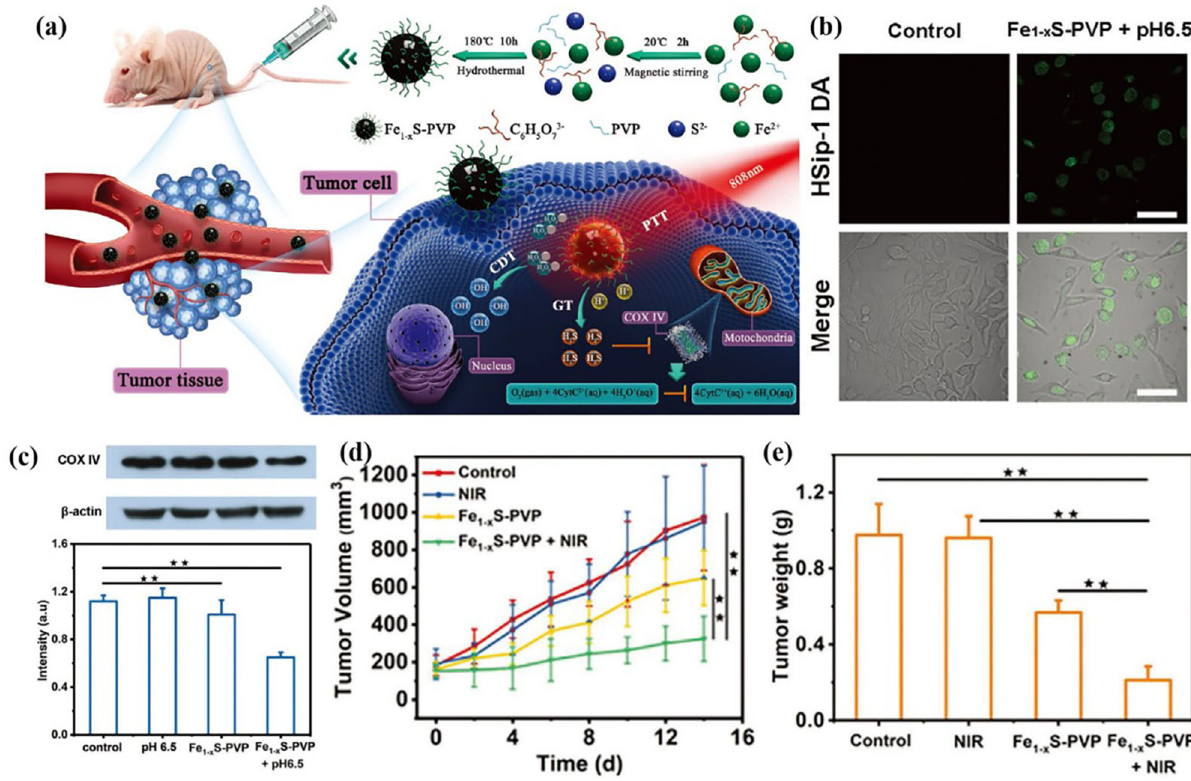
Figure 4: ( a ) Schematic illustration of the Fe 1 − x S - PVP - mediated synergistic gas therapy/PTT/CDT treatment. ( b ) CLSM images of intracellular H 2 S. Scale bar = 50 µm. ( c ) Western blot analysis and intensity of COX IV in PAN - 02 cells. ( d ) Tumor volume change of PAN - 02 tumor - bearing nude mice after various treatments ( PBS, NIR, Fe 1 − x S - PVP, and Fe 1 − x S - PVP + NIR ) . ( e ) Average tumor weight at the end of each treatment. Reprinted with permission from Ref. [ 90 ] ; Copyright © 2020 Wiley -